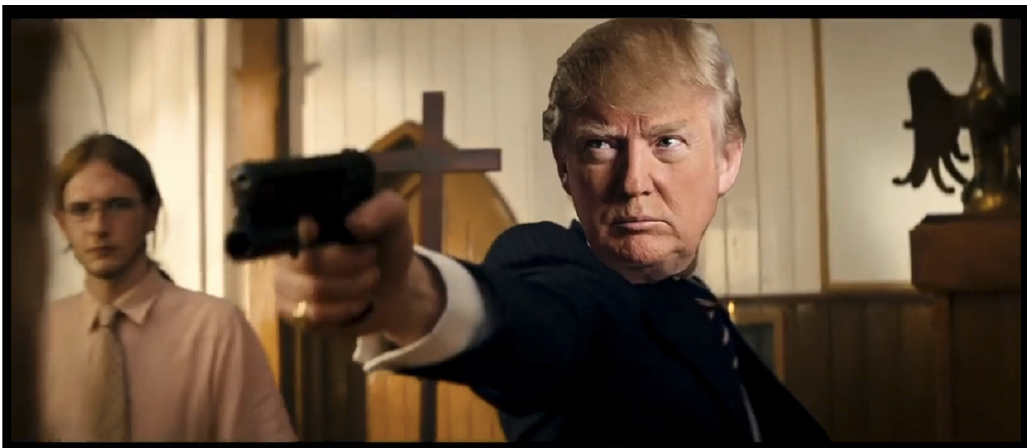
Figure 3. Donald Trump as depicted in “Trumpsmen” video, 2019. faces to depict Trump slaughtering his perceived rivals. Graphic, crude, and comical, Trump is shown shooting over 30 people as the rock anthem “Free Bird” plays in the background. The faces of the actors from the orig‐ inal movie scene are covered with bubbles depicting individuals and institutions perceived to be anti‐Trump.